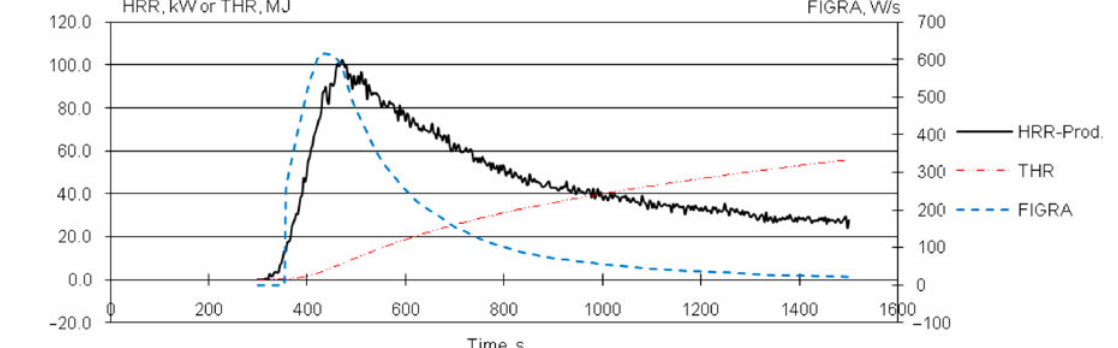
Fig. 5. HRR of non-impregnated 24 mm